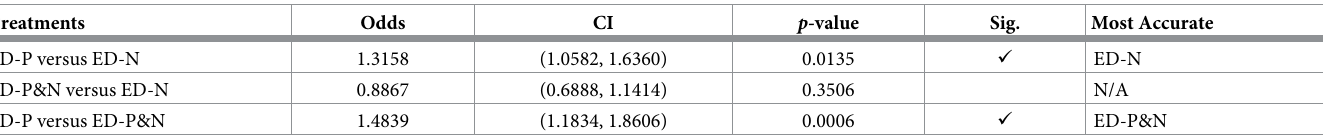
Table 3. ED : Overall accuracy analysis.